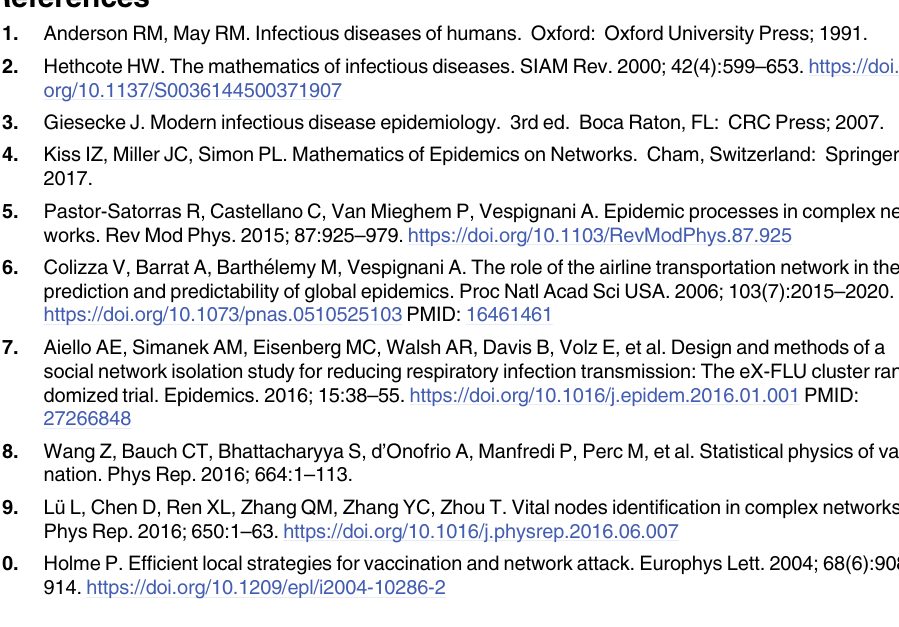
S3 Fig. How the expected outbreak size O varies with a centrality measure and the edge density across all small graphs. Corresponding to Fig 5 but for PageRank instead of Eigenvec- tor